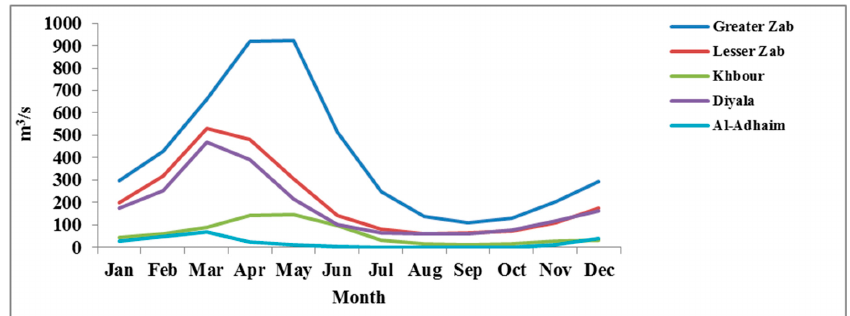
Figure 2. Average monthly flow regimes of the main Tigris River tributaries at different discharge stations (Zakho station in Khbour Basin, Eski Kalak station in Greater Zab, Dukan station in Lesser Zab, Injana station in Al-Adhaim and Derbendikhan station in Diyala) for the period from 1960 to 1990. 1. Khbour